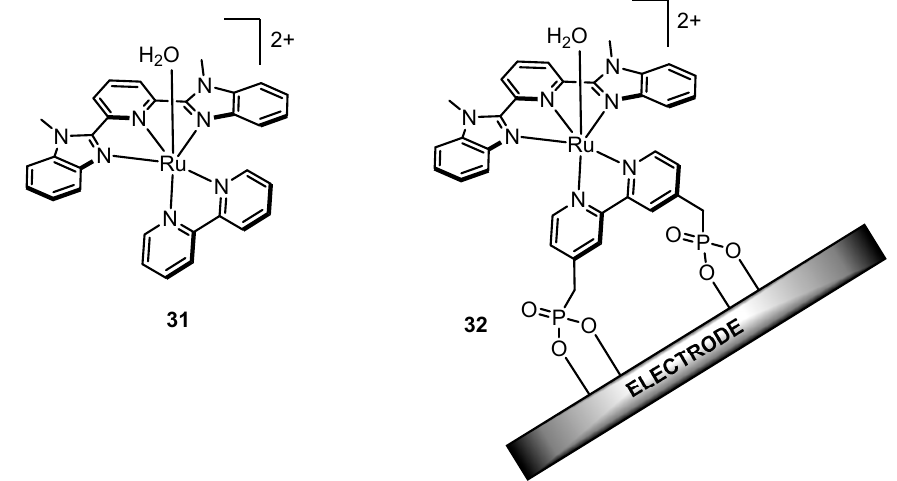
Figure 16. Complexes used by Meyer to show enhanced catalytic activity upon adding external bases.